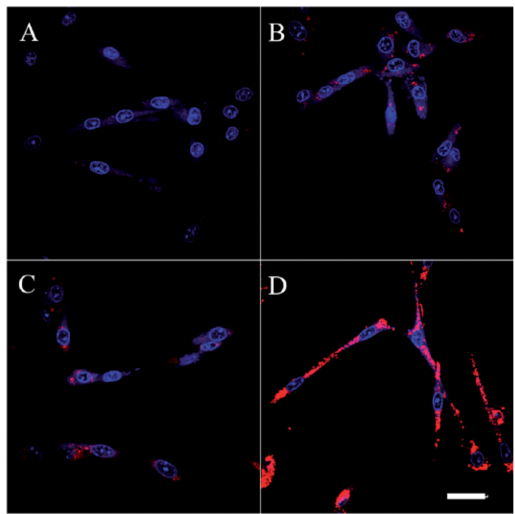
Figure 10. Confocal laser scanning microscopy (CLSM) images of fixed SKBR-3 breast cancer cells incubated with CPNP 14 -Mal ( A ); CPNP 15 -Mal ( B ); CPNP 14 -Affibody ( C ) and CPNP 15 -Affibody ( D ) at 37 ◦ C overnight. All images share the same scale bar of 30 µ m. Reproduced with permission [45]. Copyright: 2013, Royal Society of Chemistry.